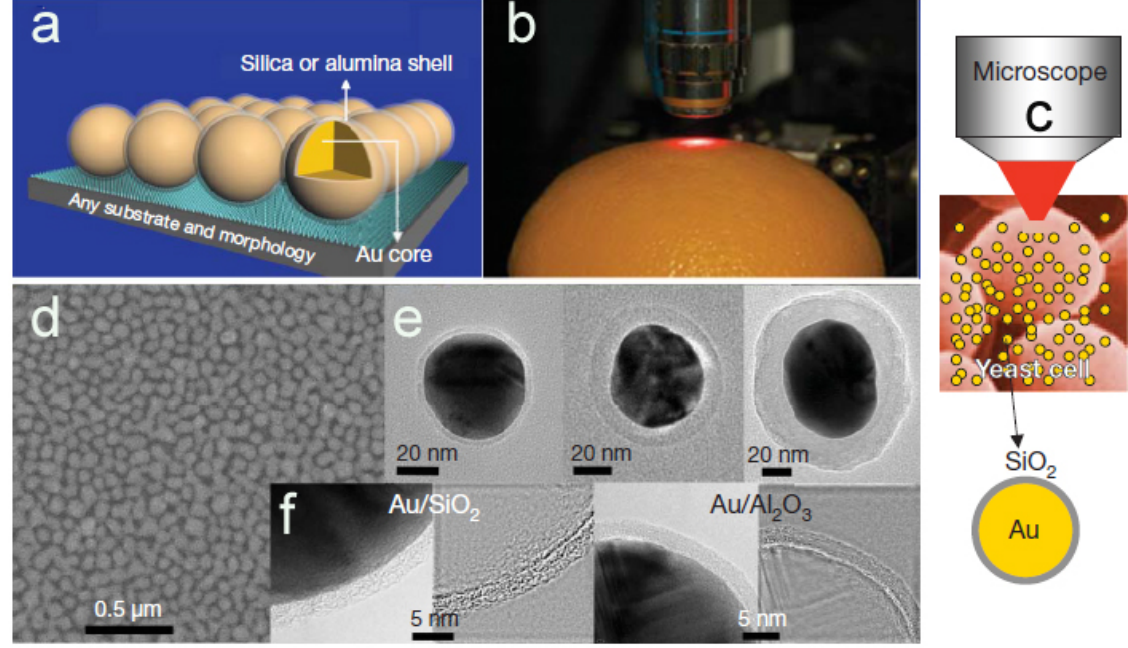
Figure 2. ( a ) The working principles of the shell-isolated nanoparticle-enhanced Raman spectroscopy (SHINERS) mode; ( b ) in situ inspection of pesticide residues on fruit by SHINERS; ( c ) in situ probing of biological structures by SHINERS; ( d ) SEM image of a monolayer of Au/SiO 2 nanoparticles on a smooth Au surface; ( e ) HRTEM images of Au/SiO 2 core-shell nanoparticles with different shell thicknesses; ( f ) HRTEM images of Au/SiO 2 nanoparticle and Au/Al 2 O 3 nanoparticle with a continuous and completely packed shell about 2 nm thick [67]. (Reproduced with permission from Li et al ., published by Nature Publishing Group,